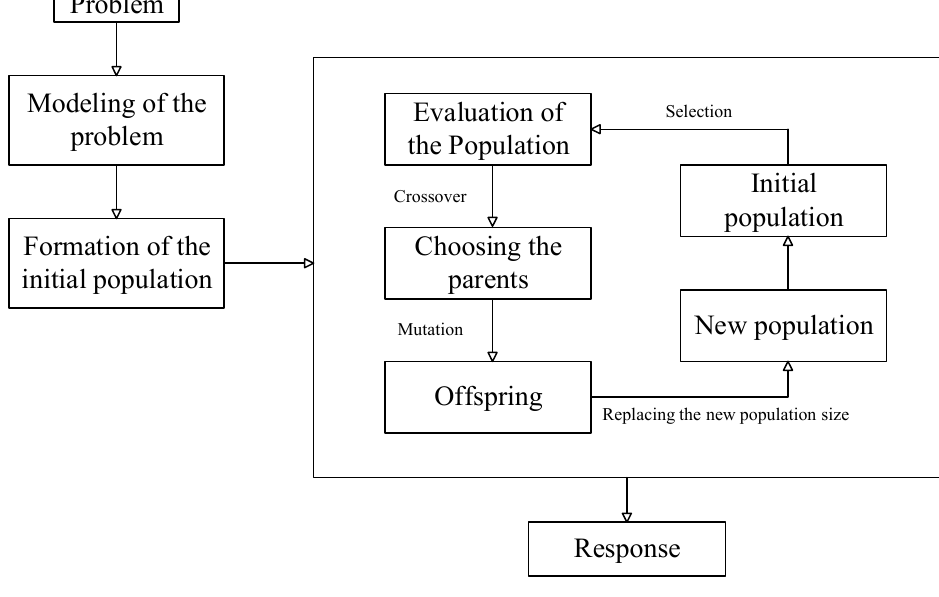
Figure 3. Genetic algorithm (GA) .